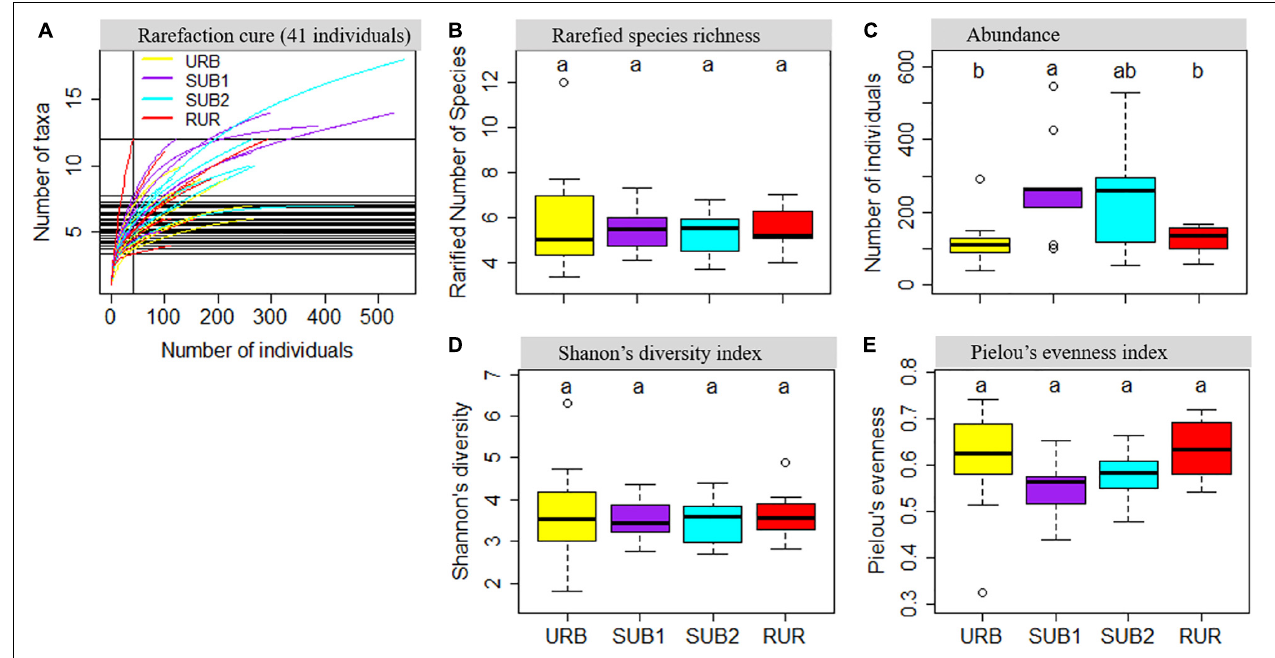
FIGURE 5 | Soil fauna biodiversity properties in urbanization gradient sites. (A) Species rarefaction curve based on 41 individuals (the lowest value in the soil fauna sampling). Boxplots showing (B) the rarefied number of species, (C) the number of collected individuals, (D) Shannon’s diversity index, and (E) Pielou’s evenness